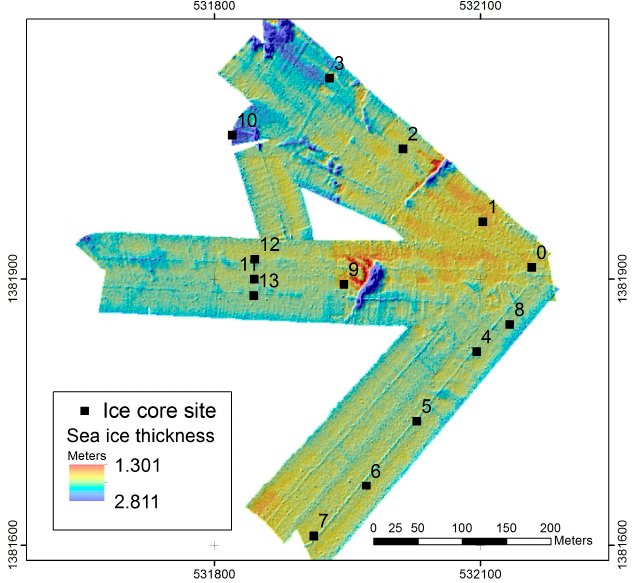
Figure 8. Map showing the location of ice cores sampled across the site at Cape Evans. Table 1. Comparison of the pressure sensor depth results with the ice core depth by difference and % difference.